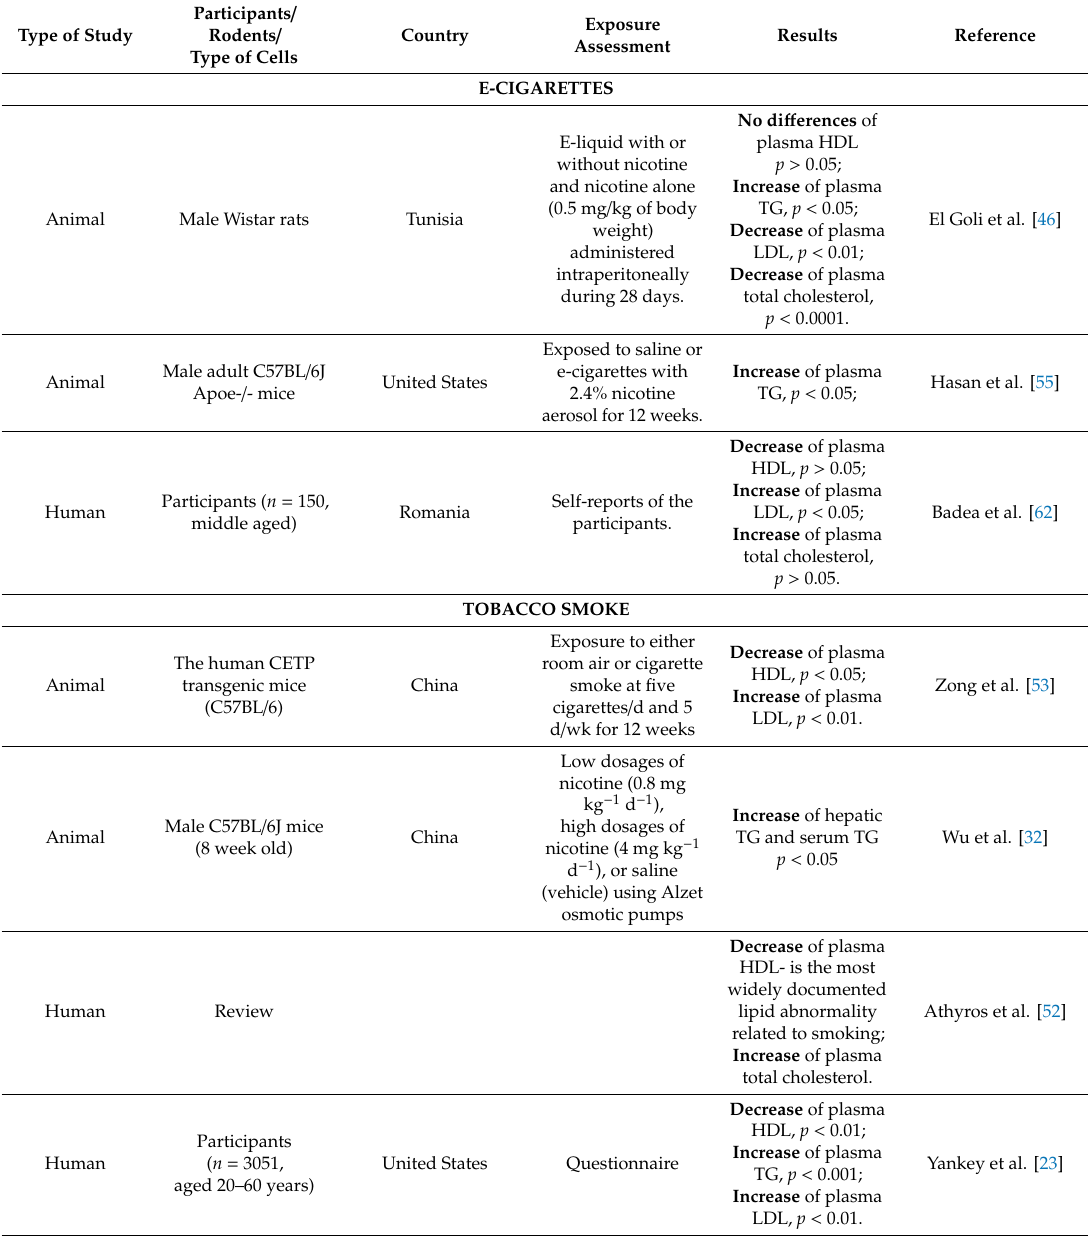
Table 4. The impact of electronic cigarettes use and tobacco smoke exposure on